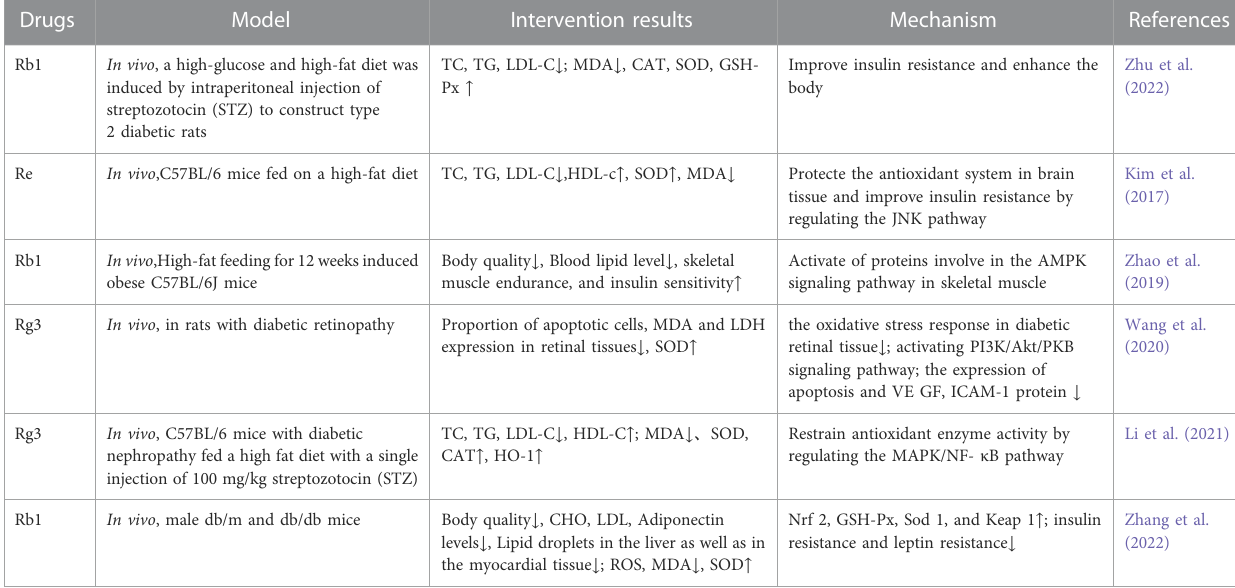
TABLE 7 Ginsenosides inhibit oxidative stress in the treatment of type 2 diabetes mellitus and its complications.